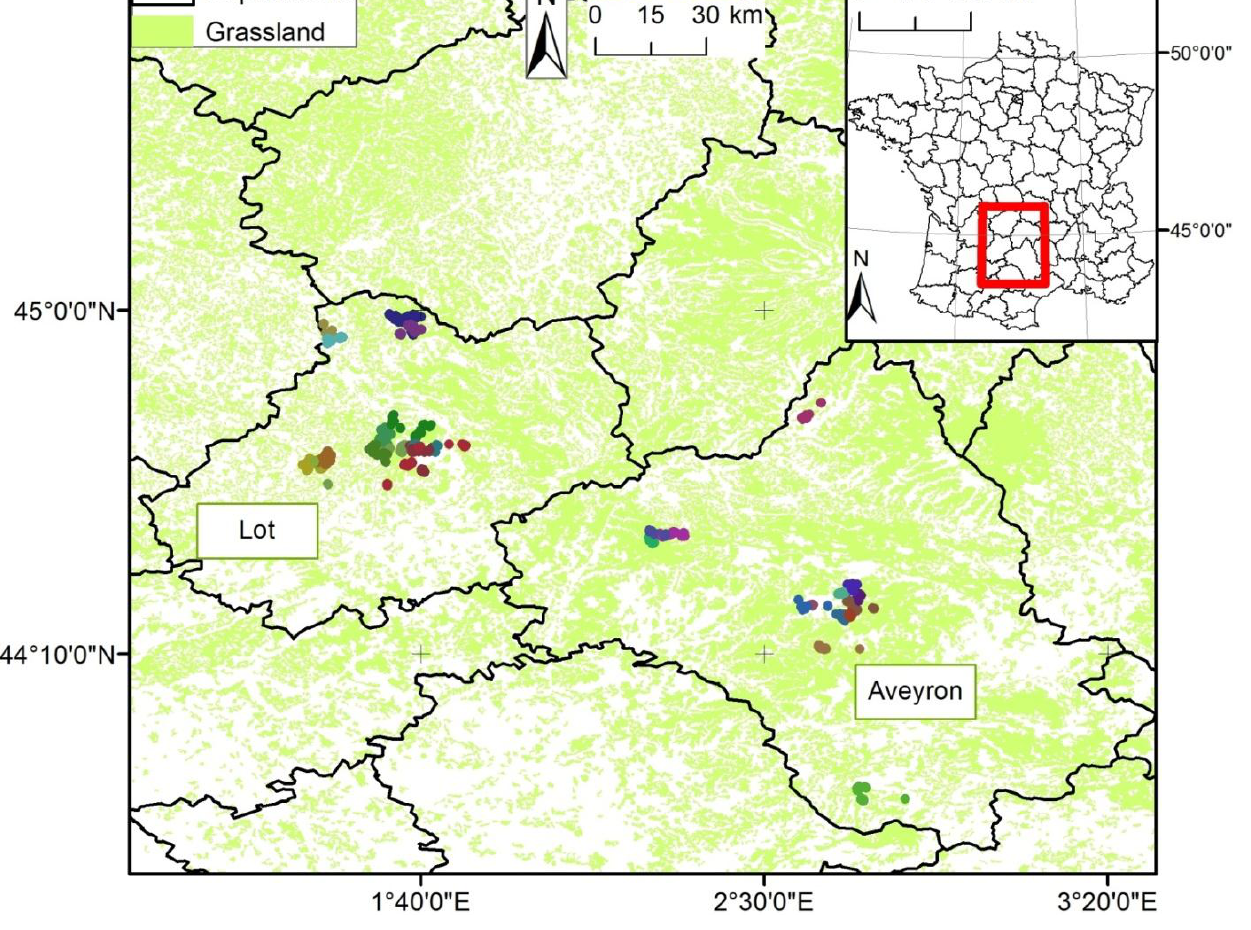
Figure 2. Sampling sites in the Lot and Aveyron departments. Colored dots represent the grassland plot sampled with each color representing one of 28 participating